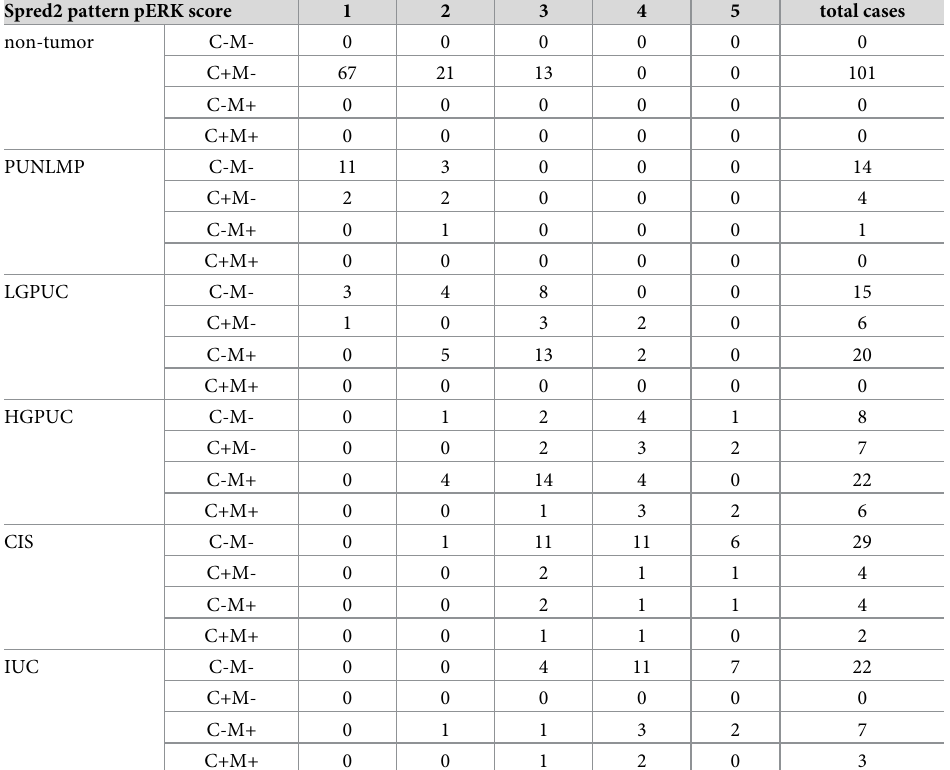
Table 3. pERK score in Spred2 immunostaining